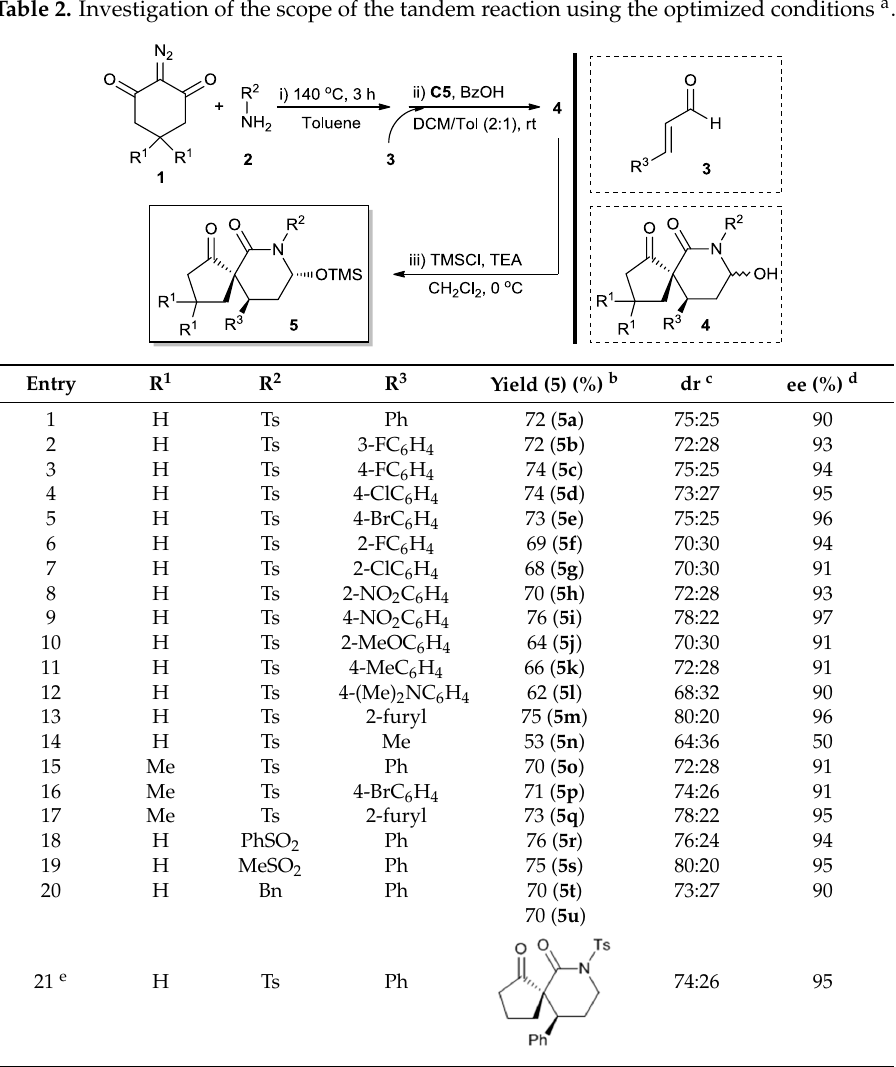
Figure 1. Oak Ridge Thermal Ellipsoid Plot (ORTEP) drawing of compound 5m . To explain the observed stereochemistry of our asymmetric organocatalytic relay tandem reaction, we propose a possible reaction transition state based on the MacMillan group’s model of the iminium intermediate (Figure 2) [49,50]. In terms of the enantioselectivity of the α , β‐ unsaturated aldehyde’s stereocenter, the steric hindrance of the benzyl group and tertiary butyl group on the catalyst framework blocks one face (up face), so the nucleophilic enol attacks from the Si face of the iminium intermediate (bottom face). Thus, the selectivity of the α , β‐ unsaturated aldehyde stereocenter can be explained. In terms of the control of the stereocenter of the ketoamide substrate, the cyclopentanone moiety with folded structure possesses more steric hindrance than the benzenesulfonyl moiety with planar structure. So, if carbon–carbon bond formation takes place from the Re face of the enol (Figure 2, left), the steric repulsion between the bulky cyclopentenol moiety of the β‐ ketoamide and the β‐ substituent of the unsaturated aldehyde could be avoided. The major isomer can be obtained with ( R , S ) ‐ configuration, which is observed in the isolated product. Otherwise, when carbon–carbon bond formation takes place from the Si face of the enol (Figure 2, right), the steric repulsion between the bulky cyclopentenol moiety of the β‐ ketoamide and the β‐ substituent of the unsaturated aldehyde is obvious, which is unfavored. O N HS